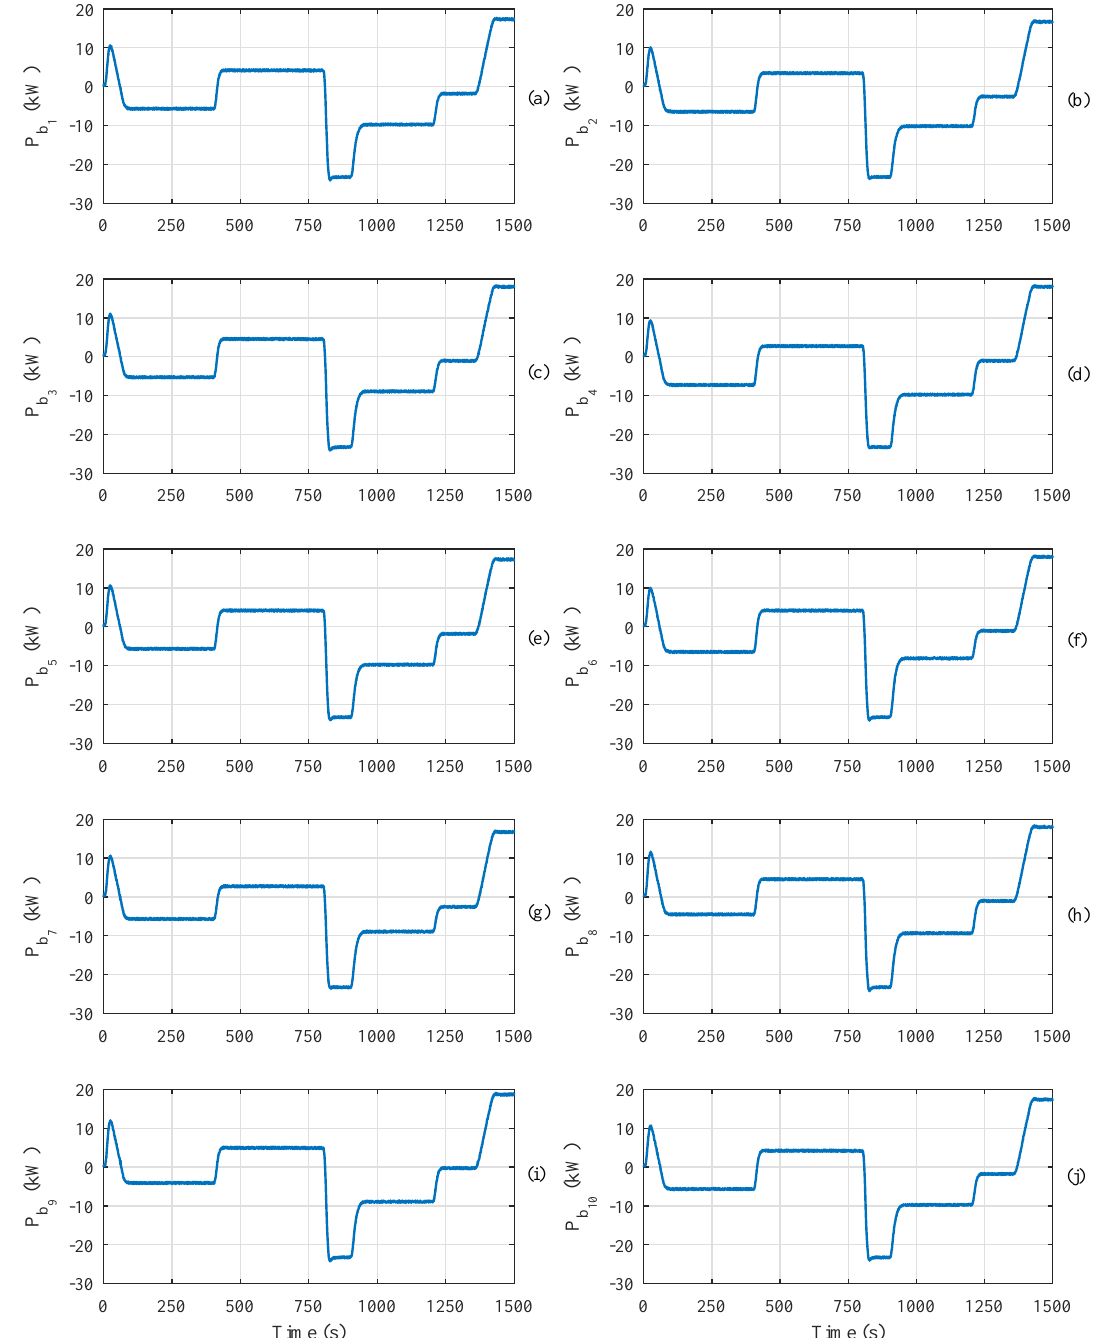
Figure 18. Powers generated/absorbed by the banks of batteries of the 10 hybrid energy storage systems (HESSs). ( a ) p b